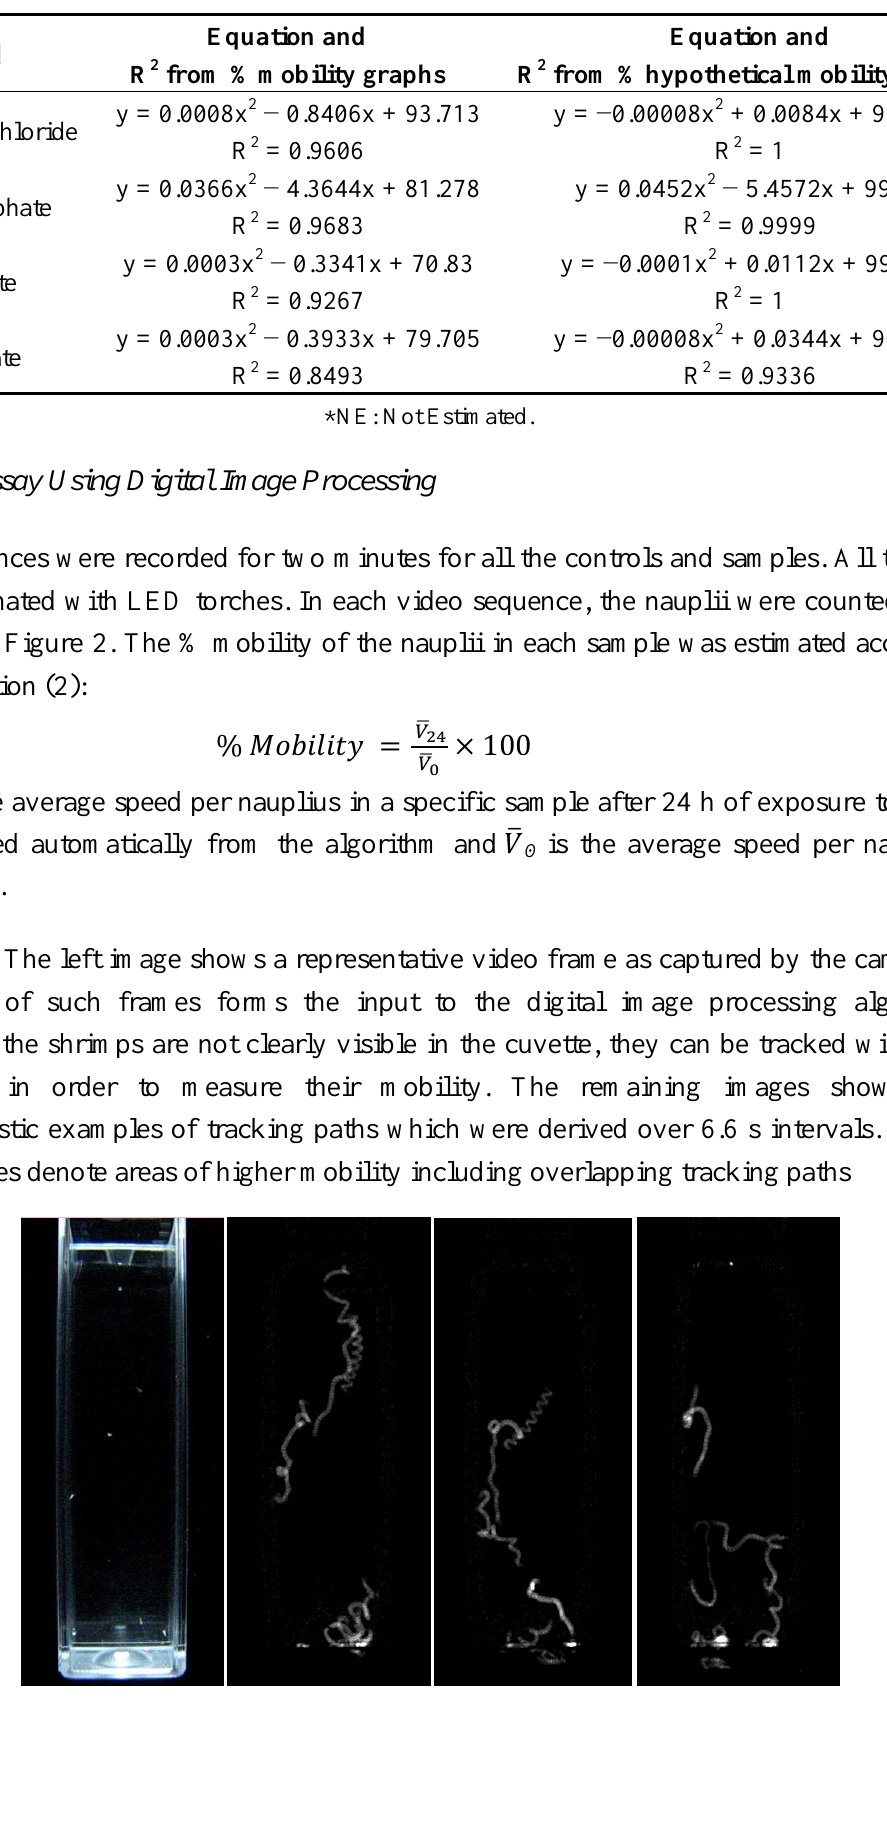
Table 1. Equations from the curves of hypothetical and measured mobility using the “best fit